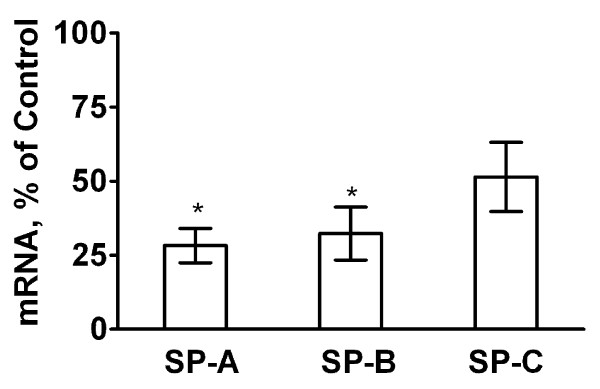
Real-time PCR of surfactant-associated protein mRNA expression in lung. Lung tissue was stored in the RNALater® buffer for extraction of total RNA. Real-time PCR was performed for quantification of mRNA levels for SP-A, SP-B and SP-C and normalized to the house-keeping gene RPL13A. To obtain ratios of normalized mRNA levels for each protein for the ASCFTR and control lung, samples were paired with respect to the day of sacrifice. The average results of triplicate samples are paired and calculated as percent of control. Results are expressed as percent change (in comparison to the control) and are mean ± SE of 5 pairs of animals for each protein. * The difference was considered significant at ≥ 50% decrease.